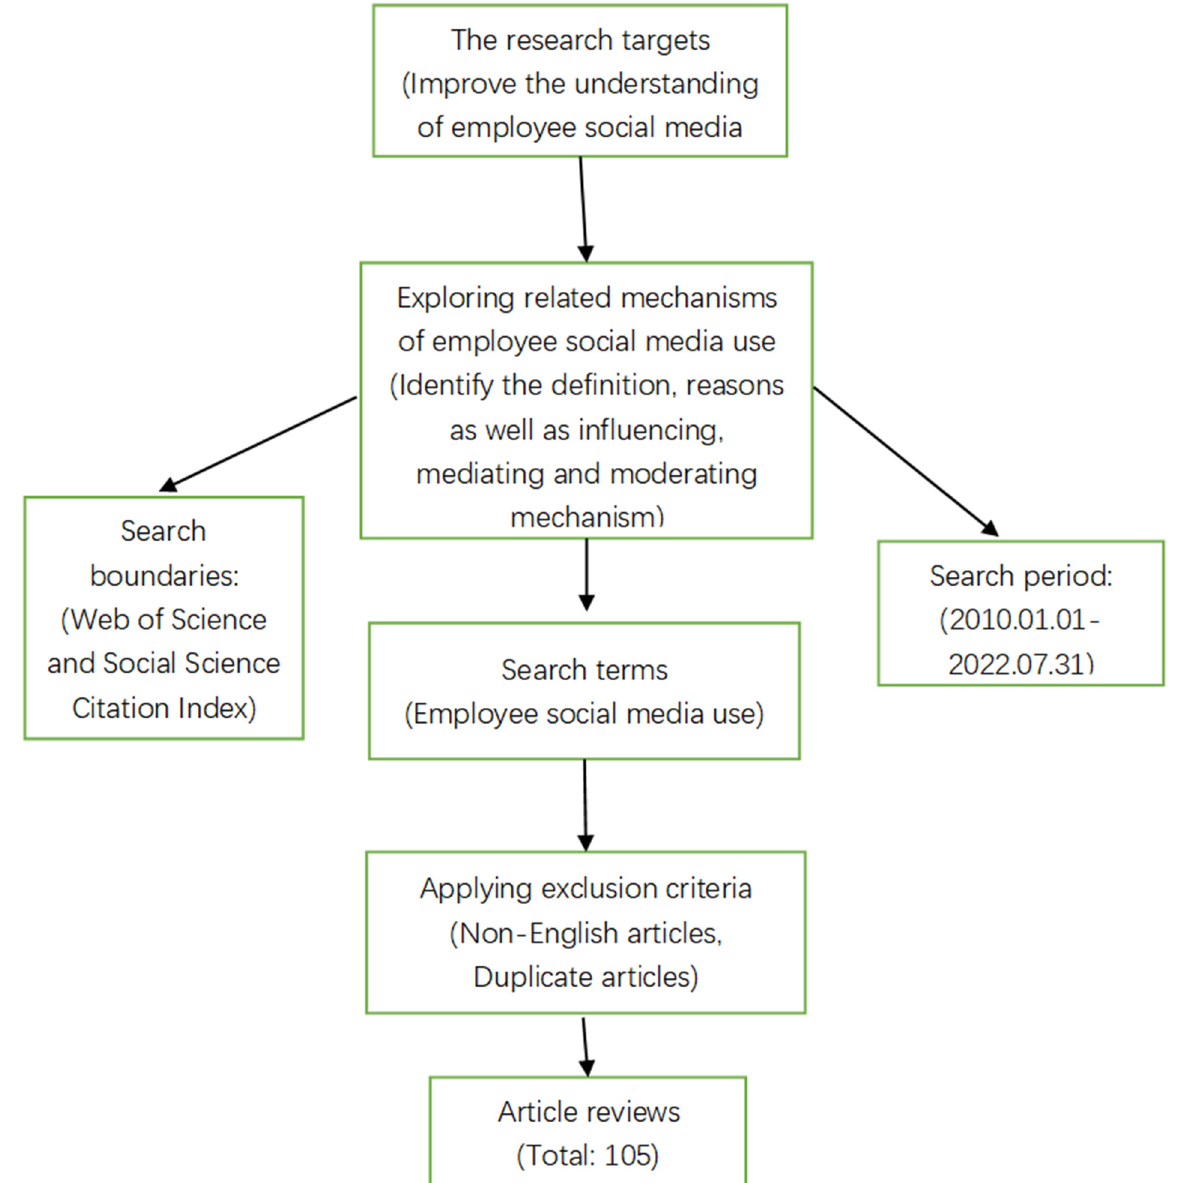
Figure 1. Research design for the scoping review.